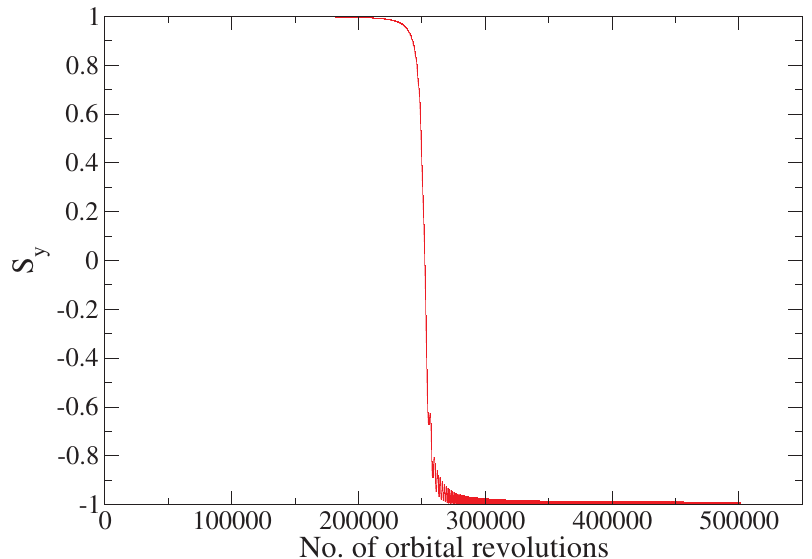
FIG. 5. (Color) This plot shows the vertical component of the spin vector as a function of number of orbital turns for a simulation done using SPINK with the RHIC lattice with all the quadrupoles included. The layout of the spin flipper setup is similar to what is shown in Fig. 3. Instead of a (cid:1) 0 ¼ 90 (cid:1) spin rotator in between the two rf dipoles, a (cid:1) 0 ¼ 30 (cid:1) spin rotator is used for this tracking and the amplitude of the spin rotation of the two rf dipoles